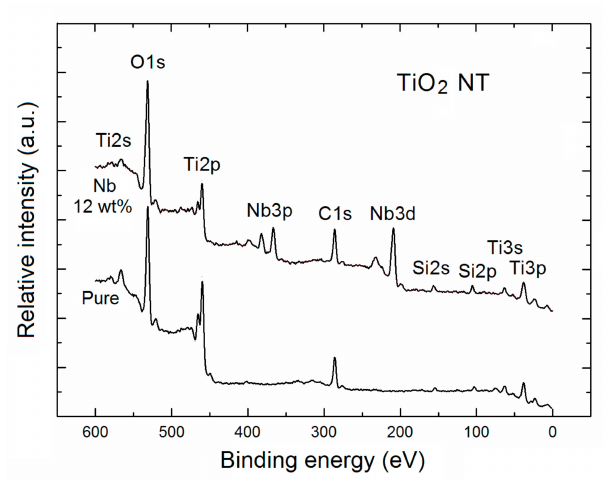
Figure 1. X-ray photoelectron spectroscopy (XPS) survey spectra of pure and Nb-doped TiO 2 nanotubes.